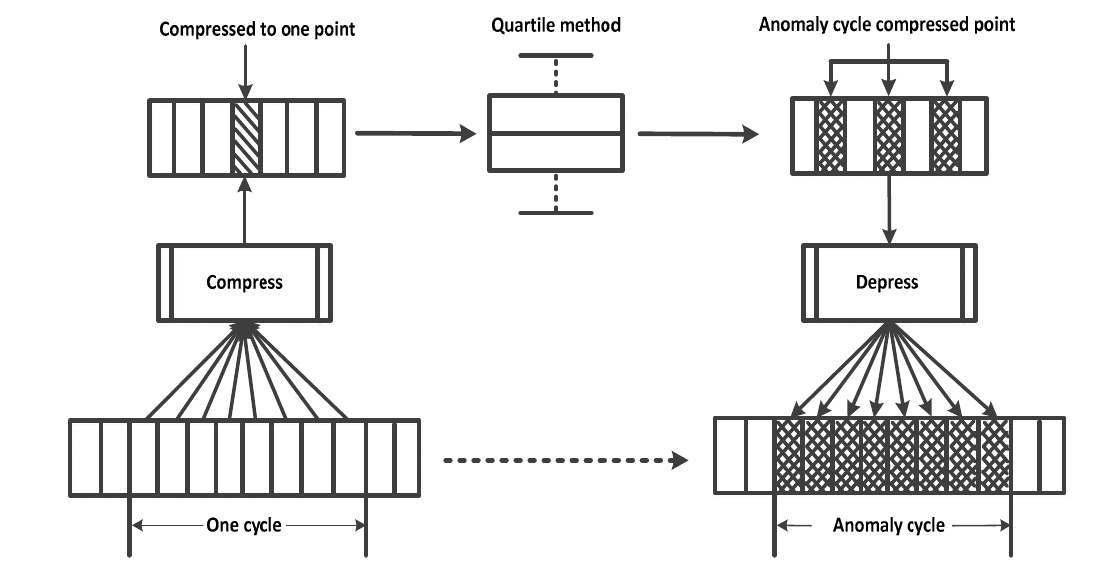
Figure 6. Demonstration of the compressed window